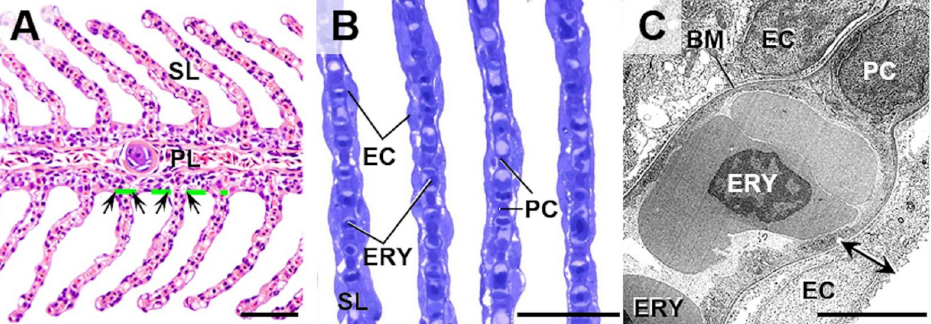
Fig 4. Gill histomorphology and ultrastructure. Important morphological structures are indicated: PL : Primary gill lamellae, SL : Secondary gill lamellae, PC : Pillar cell, EC : Epithelial cell, ERY : Nucleated erythrocyte inside a SL- capillary, BM : Basement membrane of the SL-capillary. A, B. Light-microscopic histomorphology of gill filaments (sagittal section). A. The anatomical border between the SL and the PL is indicated by arrows and a dashed green line. FFPE. HE. B. Semithin section of Epon-embedded gill filaments. Toluidine blue (TB) staining. Bars = 50 μ m. C. Ultrastructure of the secondary gill lamella. The oxygen diffusion barrier between the epithelial surface of the SL and the capillary lumen is indicated by a double arrow. Transmission electron micrograph. Bar = 5 μ m.